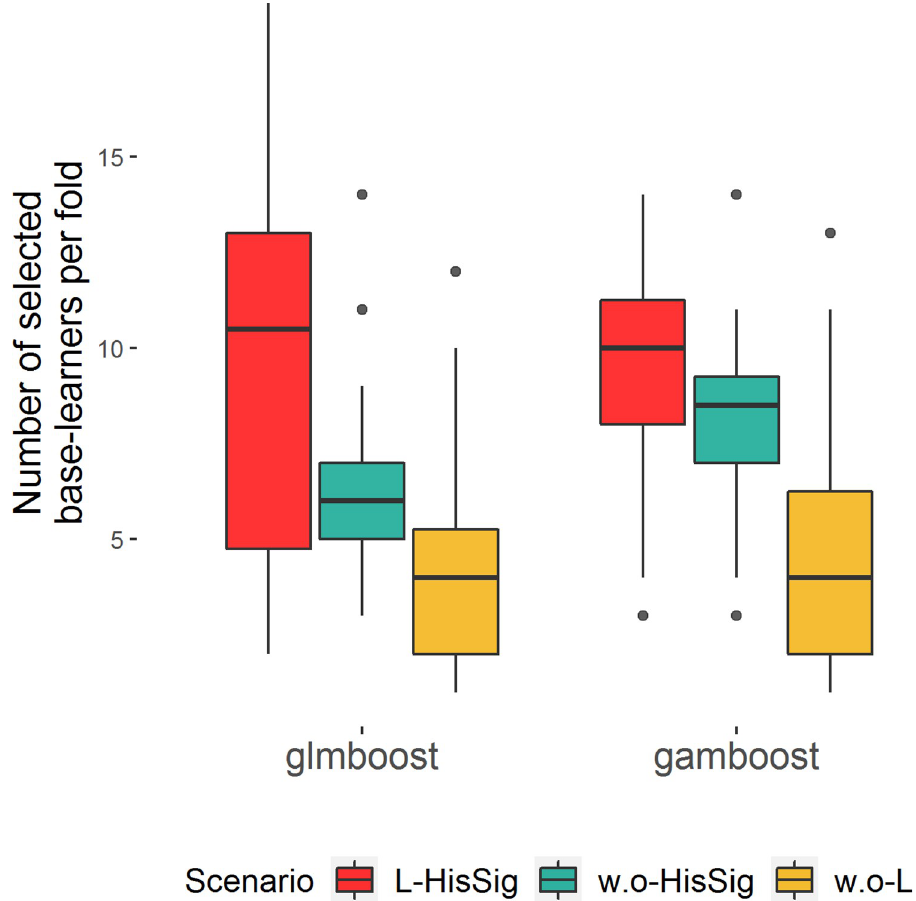
Fig 6. Number of selected assays by glmboost and gamboost in all scenarios. Each boxplot summarizes the results of 40 subsamples generated by repeated stratified 4-fold cross-validation in the respective scenario L-HisSig (red), w.o- HisSig (green) and w.o-L